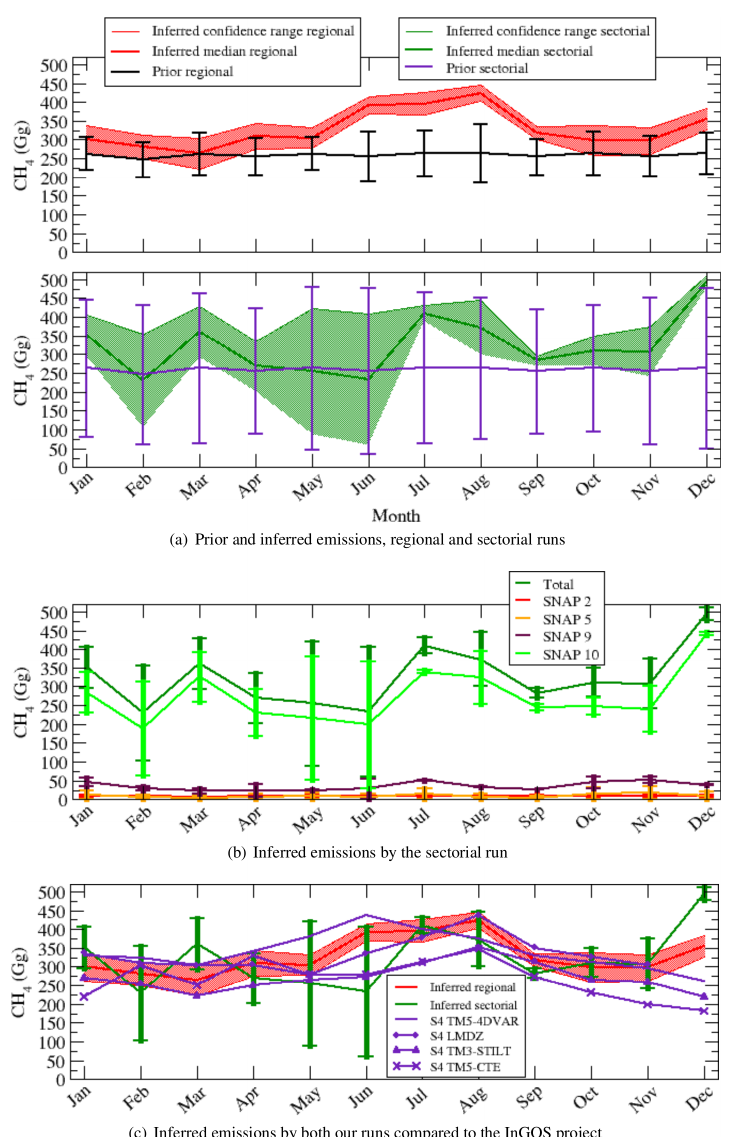
Figure 8. CH 4 monthly emissions (in GgCH 4 ) in France in 2012 by the regional and sectorial runs. (a) Prior fluxes (provided as detailed in Sect. 3.4.2) with the uncertainty computed by our method (Sect. 2.3) and confidence range of inferred fluxes with the median shown as a solid line (Sects. 2.3 and 4.2). (b) For the sectorial run: details of inferred monthly emissions for the four SNAPs which are actually seen by the inversion. c) Comparison of both runs to the inversions “S4” in the InGOS project for which monthly emissions are available (Bergamaschi et al.,